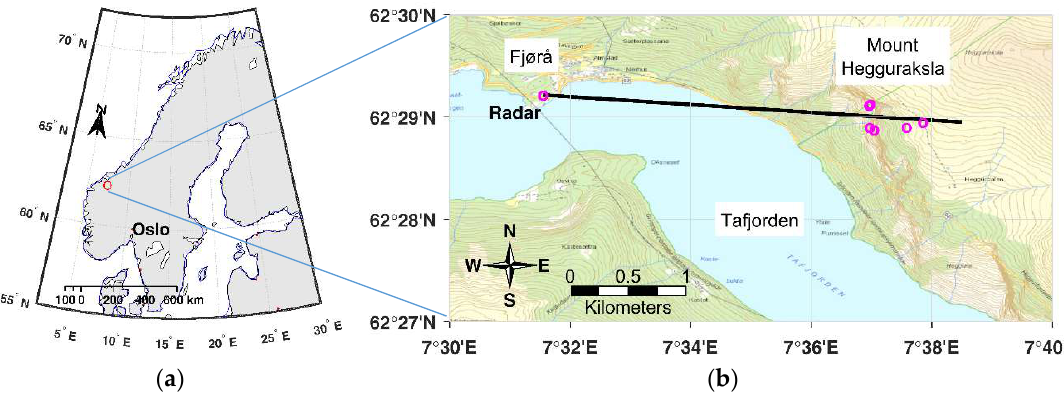
Figure 1. Two maps showing the location of the radar. ( a ) Overview map showing where in Norway the radar is located. ( b ) Shows a detailed map of the studied area. The circle to the left marks the location of the radar, and the 6 circles to the right marks the monitored mountain area. The black line marks the pointing direction of the radar.